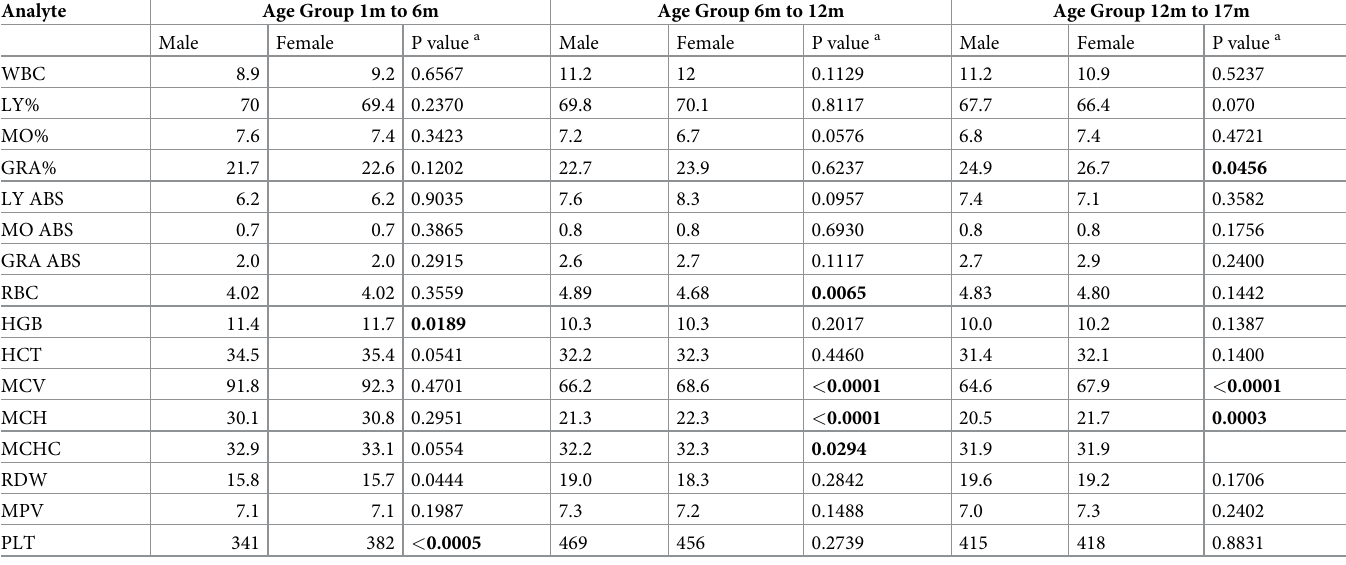
This table shows a summary of the median values in different hematological and erythrocyte indices in different age groups by gender. a Comparisons between males and females. P values in bold represent statistically significant results